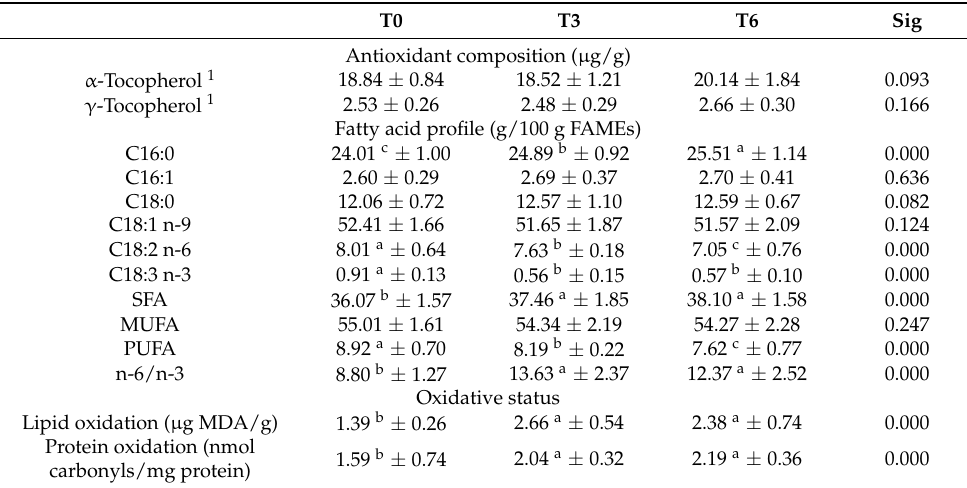
Table 2. Antioxidant content, fatty acid profile, and oxidative status of Montanera Iberian dry-cured lomito as affected by pre-cure freezing time.